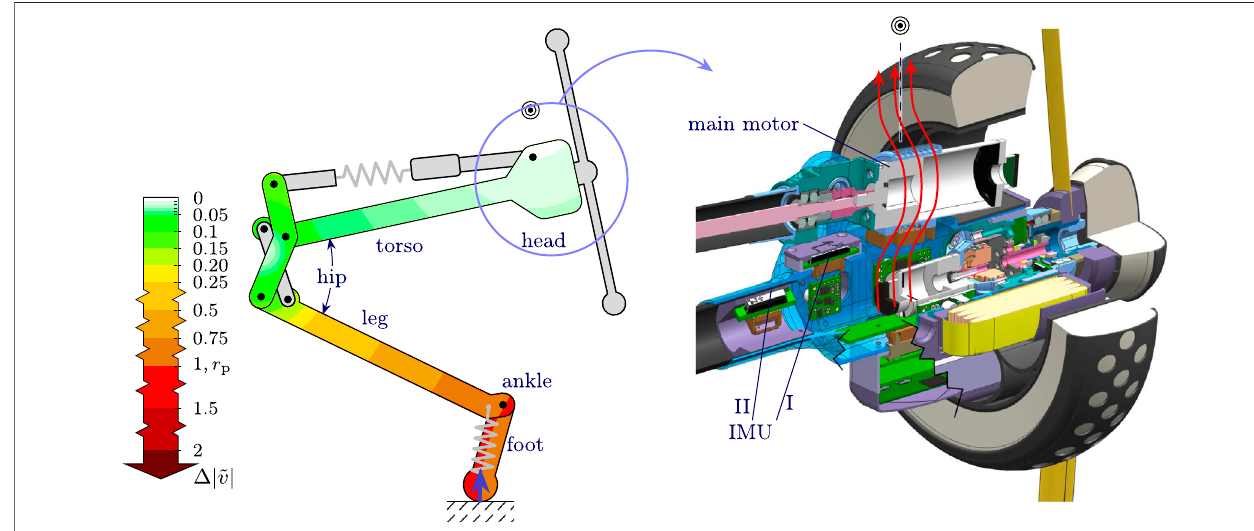
FIGURE 3 | Skippy ’ s torso ’ s CoPc ( ) for a vertical landing is shown to be inconveniently above the motor ’ s heat stream for IMU placement. Nevertheless, the overall low shock experienced by the torso (high RoPc) allow for the IMU to be placed in a location (I or II) where it experiences less than 2% of the impact shock when landing a vertical jump.